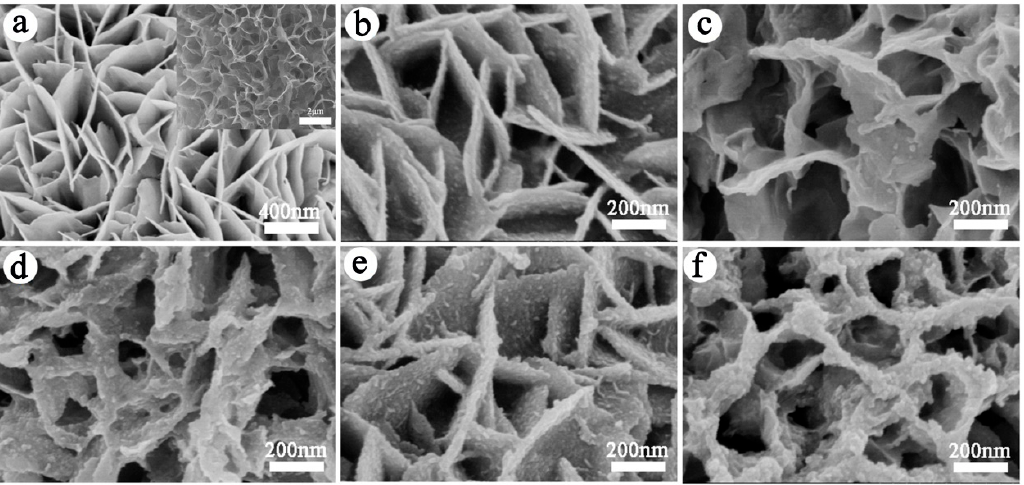
Figure 2. SEM images of ( a ) Co 3 O 4 /CC, inset: CoS/CC; ( b – f ) Co 3 O 4 @CoS/CC at 1, 2, 3, 4, 5 cycles electrodeposition, respectively.